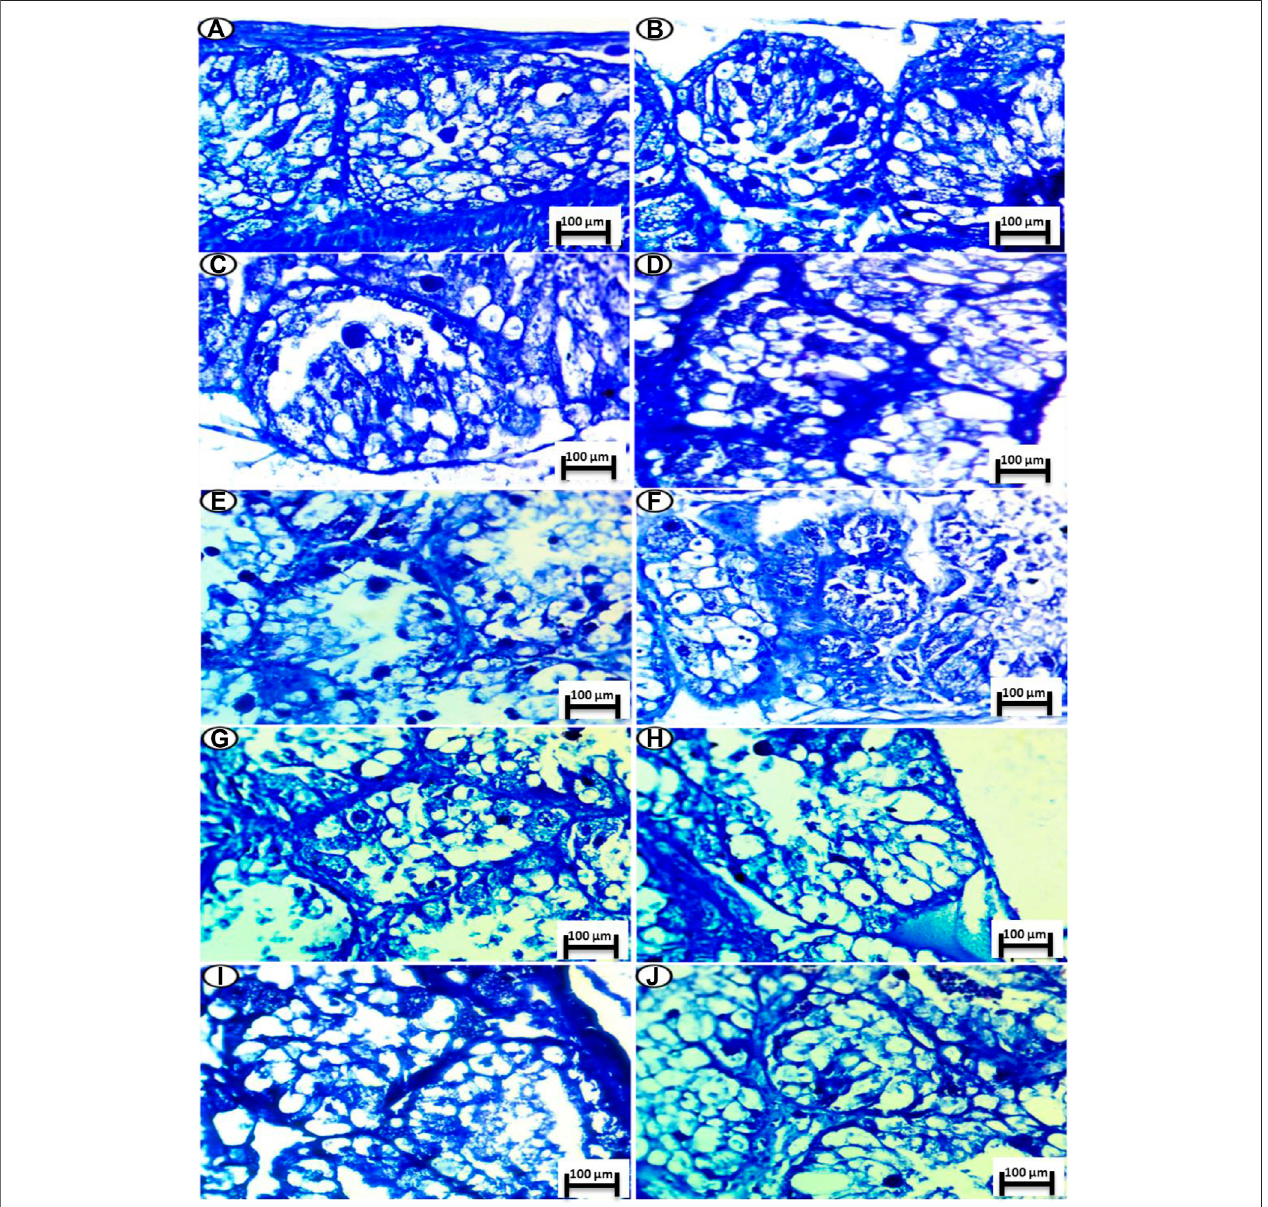
FIGURE5| Photomicrograph ofdigestive gland ofSlug Lehmannianyctelia after the exposure to (A,B) Control group, (C) ;0.04 g/LofAgNPs, (D) ;0.08 g/LofAg NPs, (E) ; 0.4 g/Lof Ag NPsand (F) ; 0.8 g/L of AgNPs, (G) ; 0.04 g/L of silver nitrate, (H) ; 0.08 g/L ofsilver nitrate, (I) ; 0.4 g/L of silver nitrate, (J) ; 0.8 g/L ofsilver nitrate. (Toluidine blue, scale bar 100 μ